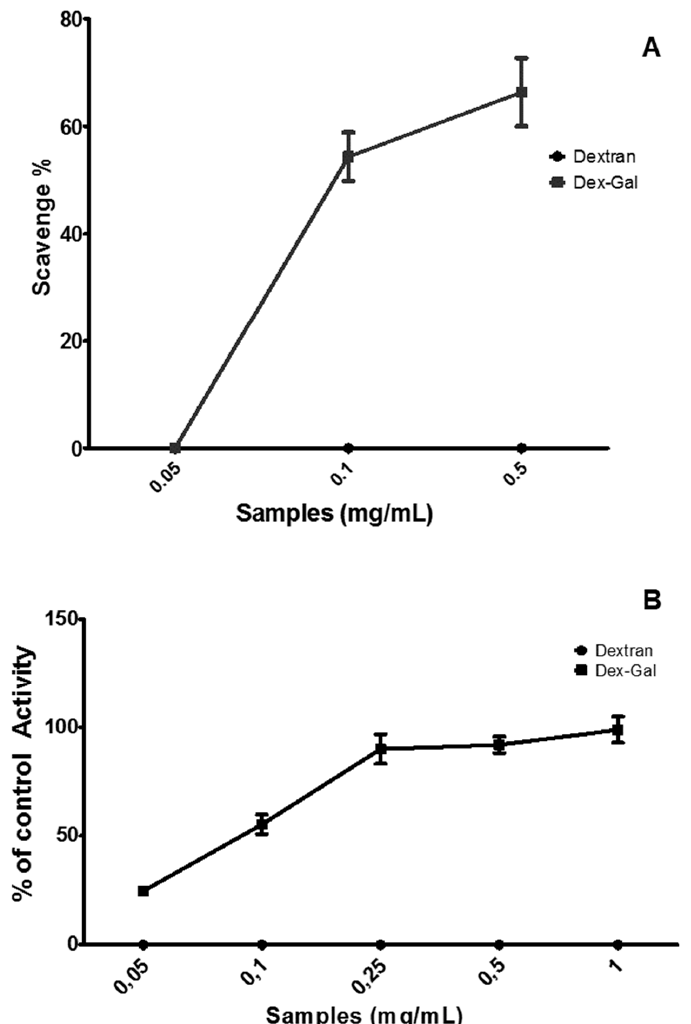
Figure 4. Antioxidant activities of dextran and Dex–Gal. ( A ) Superoxide scavenging activity. ( B ) Reducing power. Dextran ( • ) Dex–Gal ( ▪ ). The activity was analyzed with one-way ANOVA ( p < 0.05).